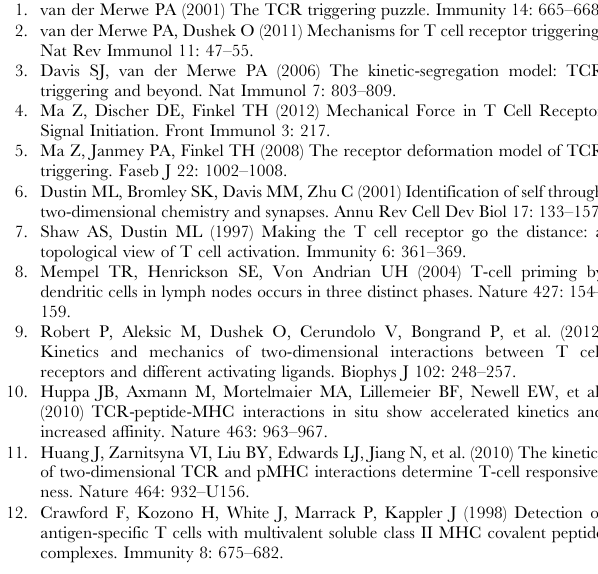
Figure S6 Snapshot of the molecular dynamics simulation. The PEG-bilayer system was simulated as a function of PEG length (from 4000 to 20000 Dalton as shown in red) with a distance of 9 nm between the fixed end of the polymer and the center of the bilayer to examine how polymer length (chain entropy) affects both the rate and affinity of binding. (TIF) Figure S7 Linear regression trend lines and equations are displayed for Fig. 4B to show the rate of T cell commitment to IL2 production. (TIF) Figure S8 Flow cytometry plots for the three experiments done for Fig. 4A. At least 5000 live cells were collected for each sample. Note that in Experiment # 1, IEkMCC-PEG 88 was not assayed. (TIF) Figure S9 Flow cytometry plots for the three experiments done for Fig. 4B. At least 5000 live cells were collected for each sample. Note that only three time points were assayed in Experiment # 1. (TIF) Text S1 CG-MD